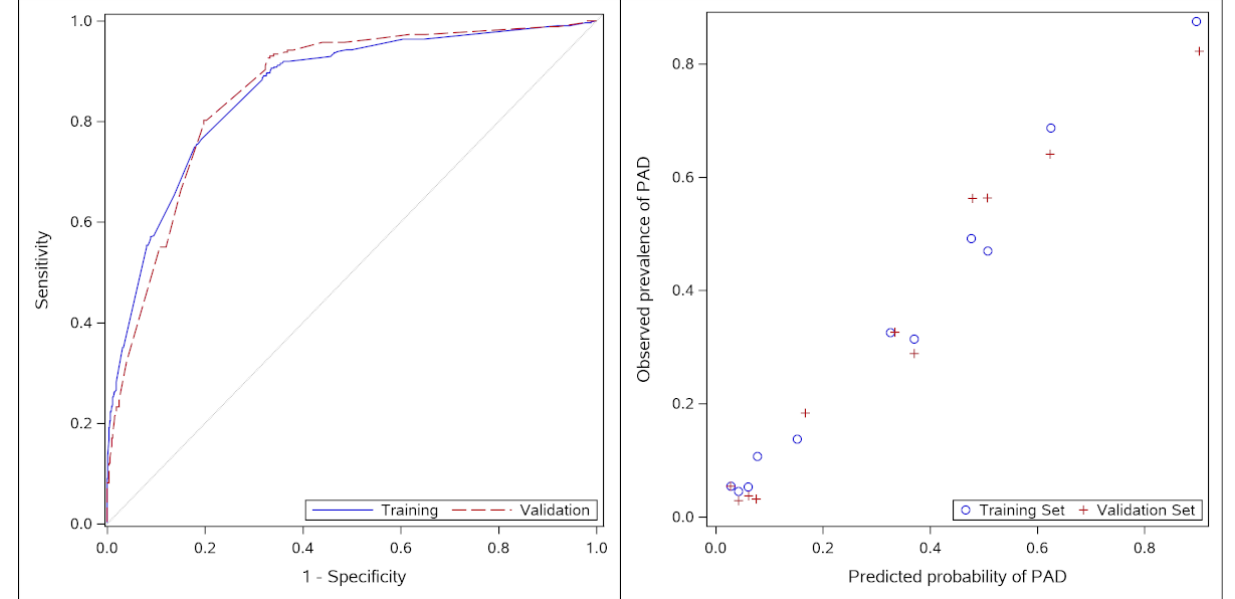
Figure 2. Comparison of results from training and validation sets. Left panel: receiver operating characteristic curves for training and validation sets. Right panel: Comparison of deciles of predicted probabilities in training set versus validation set. PAD: peripheral artery